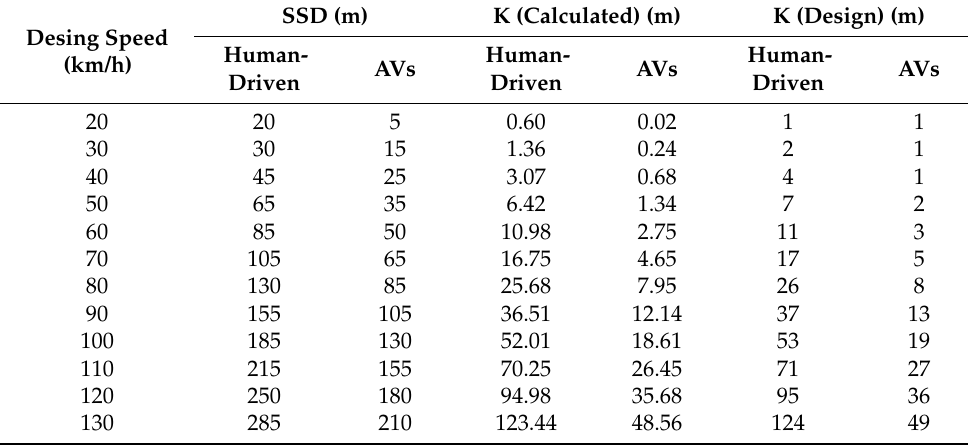
Table 4. Design Controls for Crest Vertical Curves Based on Stopping Sight Distance for human- driven and